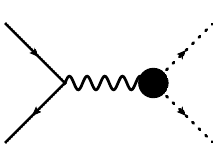
Figure 1 . Tree-level Feynman diagram leading the production of Wh and Zh via the annihilation of q ¯ q ′ quarks into a gauge W ± ( Z ) boson. Strong rescattering in the final state appears through the form factor A ( s ) represented by the thick F